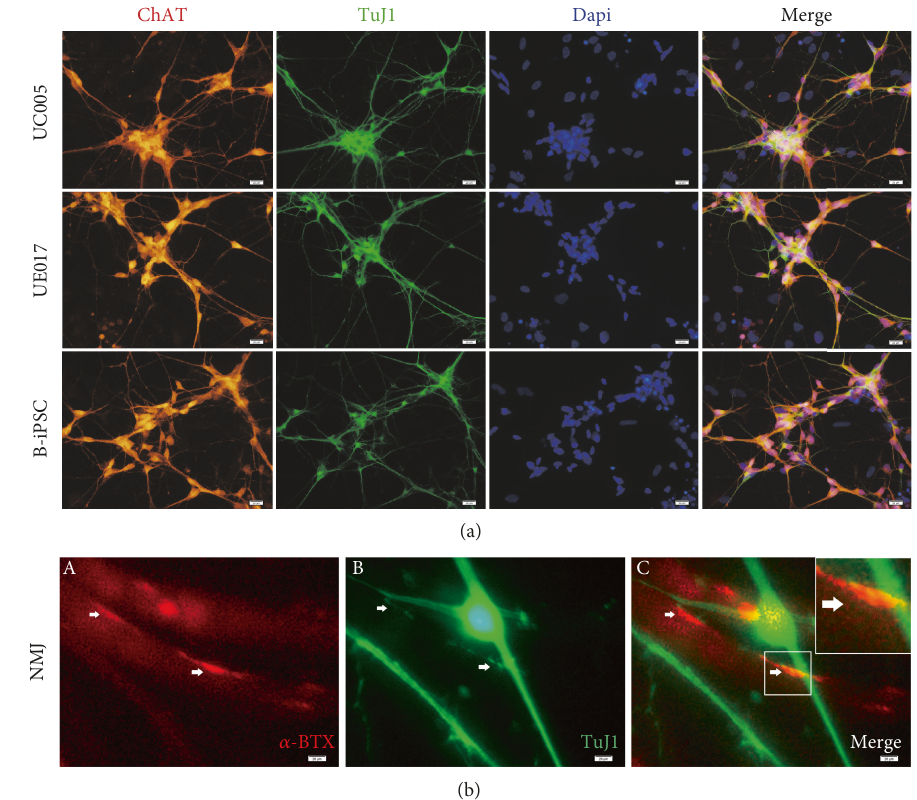
Figure 6: Mature and functional MNs were generated after 26 days of di ff erentiation. (a) Immunocytochemical staining of mature MNs. Under inductive conditions for more than 26 days, cells derived from all three iPSC lines, B-iPS, UE017, and UC005, expressed the mature MN marker choline acetyltransferase (ChAT). They also expressed the neuronal marker TuJ1. Cell nuclei were counterstained with 4 ′ ,6-diamidino-2-phenylindole (DAPI). (b) Cocultured muscle cells and MNs form neuromuscular junctions. Immuno fl uorescence staining shows α -bungarotoxin- (BTX-) positive sites overlaid with TuJ1 labeling in the UC005 MNs (A, B, C). Cell nuclei were counterstained with 4 ′ ,6-diamidino-2-phenylindole (DAPI). The scale bar is 50 μ